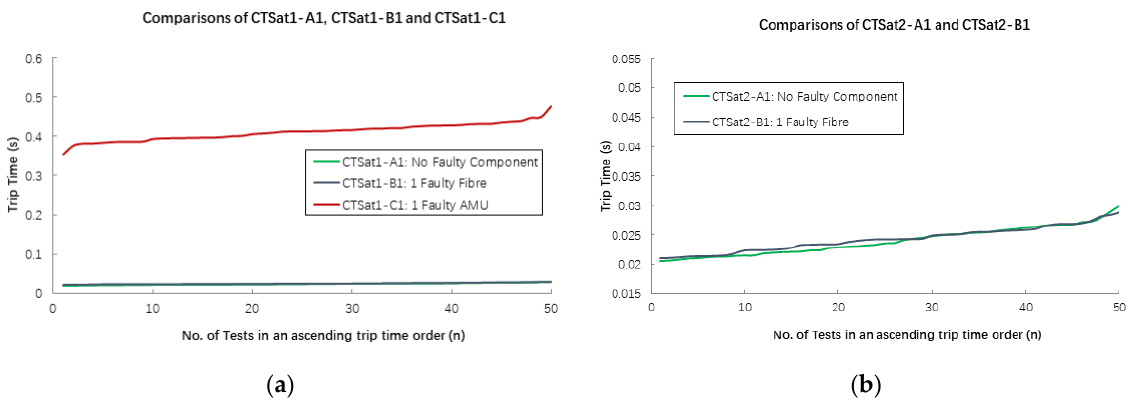
Figure 19. Comparisons: ( a ) CTSat1-A1, CTSat1-B1 and CTSat1-C1 (light CT saturation, no/one faulty component, 3Ph-G fault at 50% of the feeder); ( b ) CTSat2-A1 and CTSat2-B1 (deep CT saturation, no/one faulty component, 3Ph-G fault at 50% of the feeder).